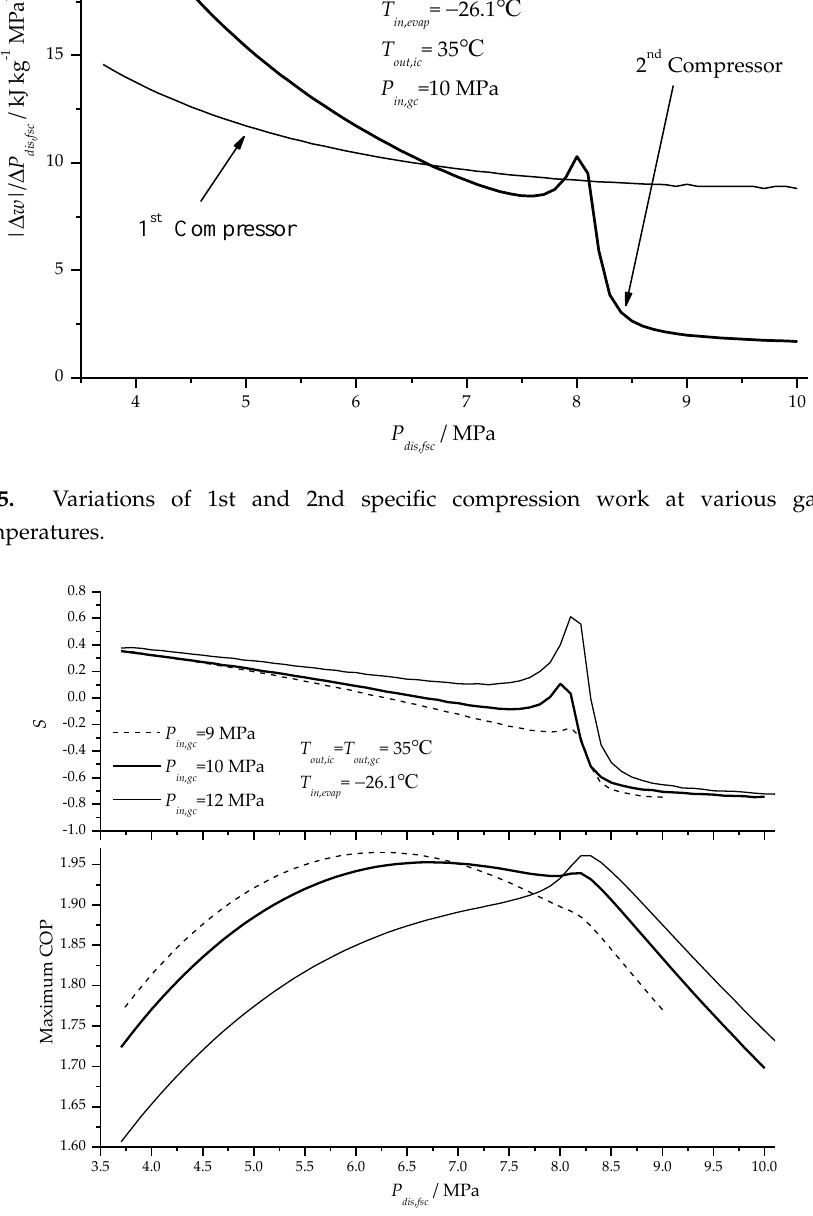
Figure 16. Sensitivity of COP to inter-stage pressure at various gas cooler inlet pressures.